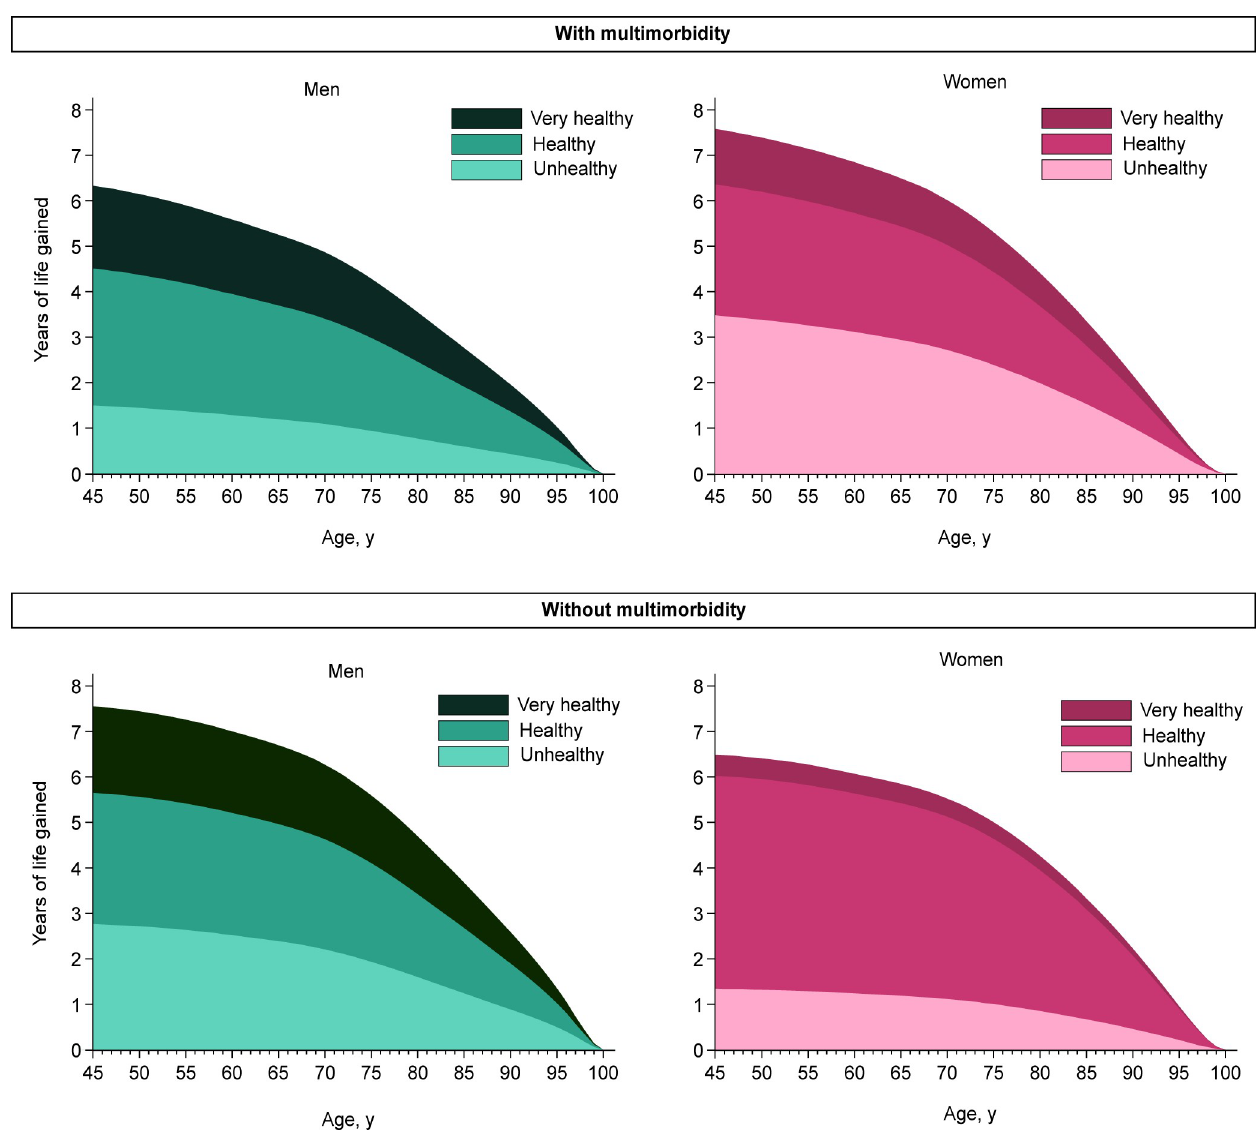
Fig 2. Years of life gained by lifestyle score. Reference group is the very unhealthy group. Models adjusted for ethnicity (white, non-white), working status (working, retired, other), deprivation (continuous), body mass index (continuous), sedentary time (continuous).